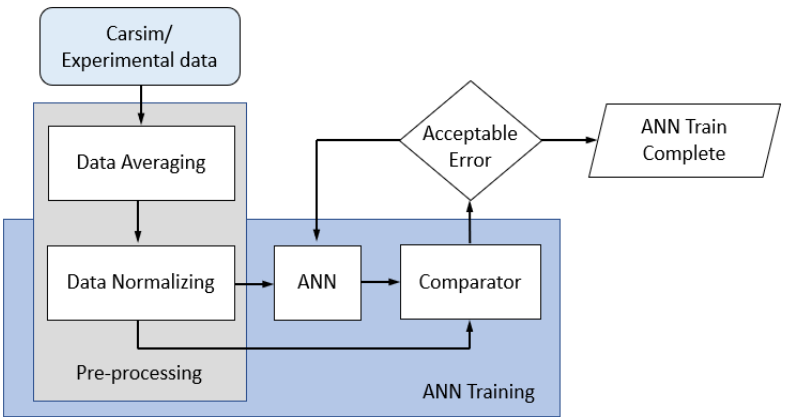
Figure 10. ANN training diagram.